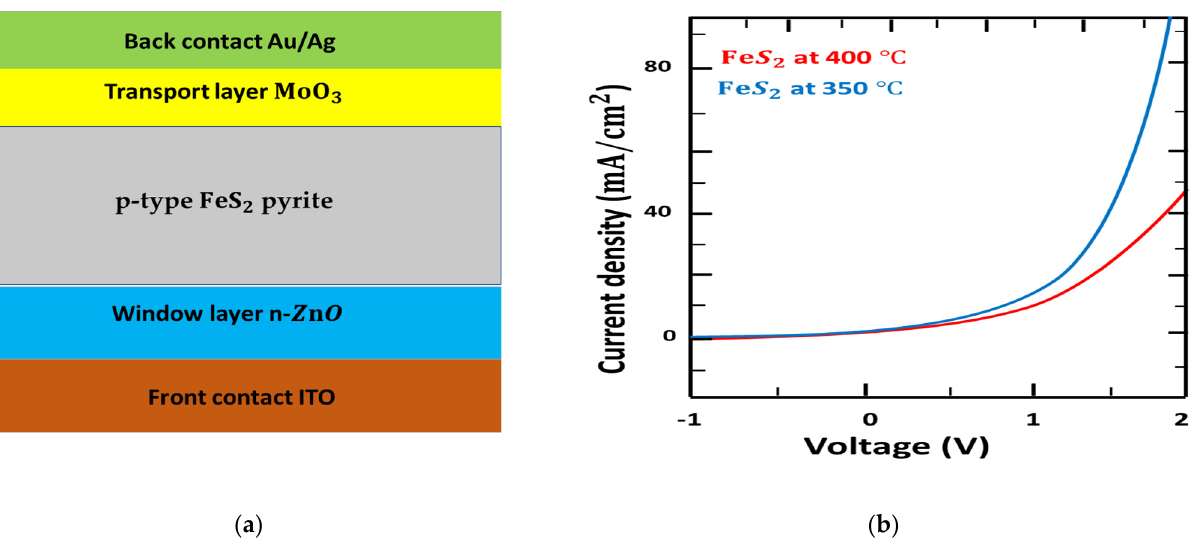
Figure 7. ( a ): Device structure of ITO/ZnO/FeS 2 / MoO 3 /Au/Ag . ( b ): Current density versus voltage (J − V) characteristics of fabricated solid solar cells.